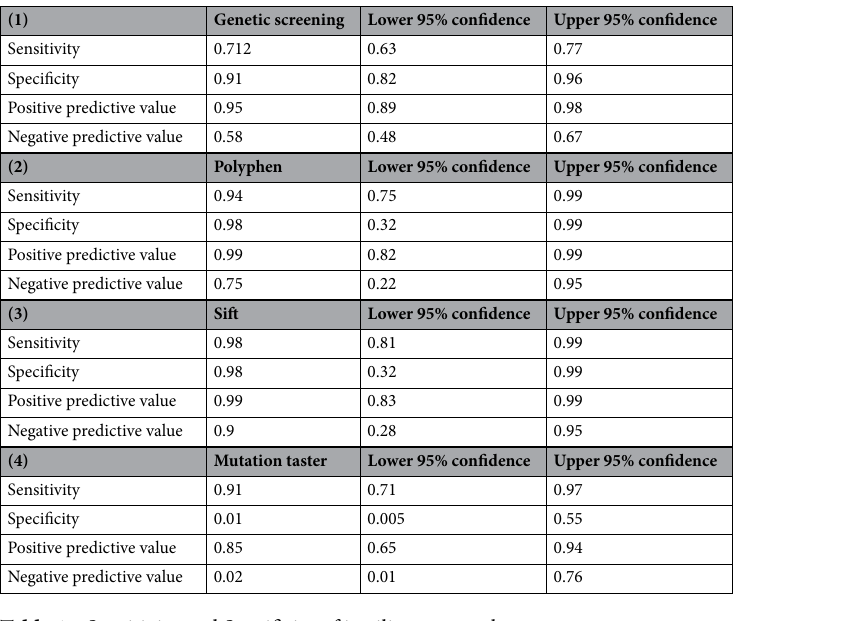
Table 1. Sensitivity and Specificity of in silico